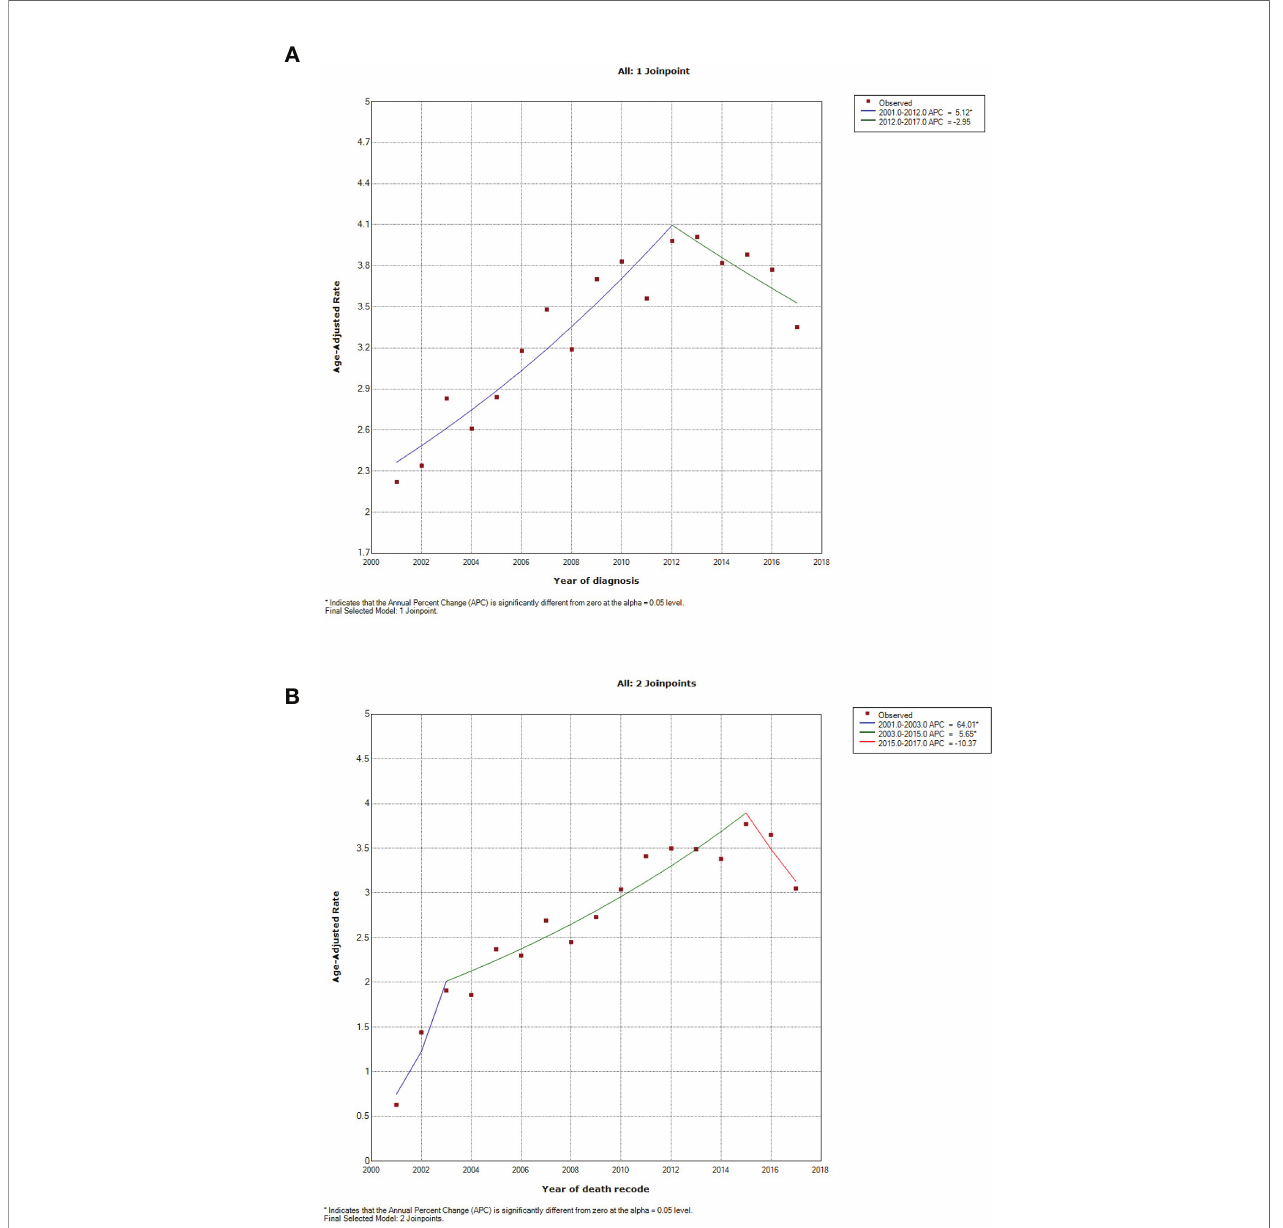
FIGURE 3 | Incidence and mortality trends in patients with pulmonary large cell neuroendocrine carcinoma between 2001 and 2017. (A) incidence, using Incidence- SEER Research Data with 18 Registries (November 2019 Submitted); (B) mortality, using Incidence-Based Mortality-SEER Research Data with nine